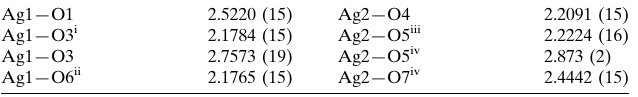
Selected bond lengths (A˚ ).